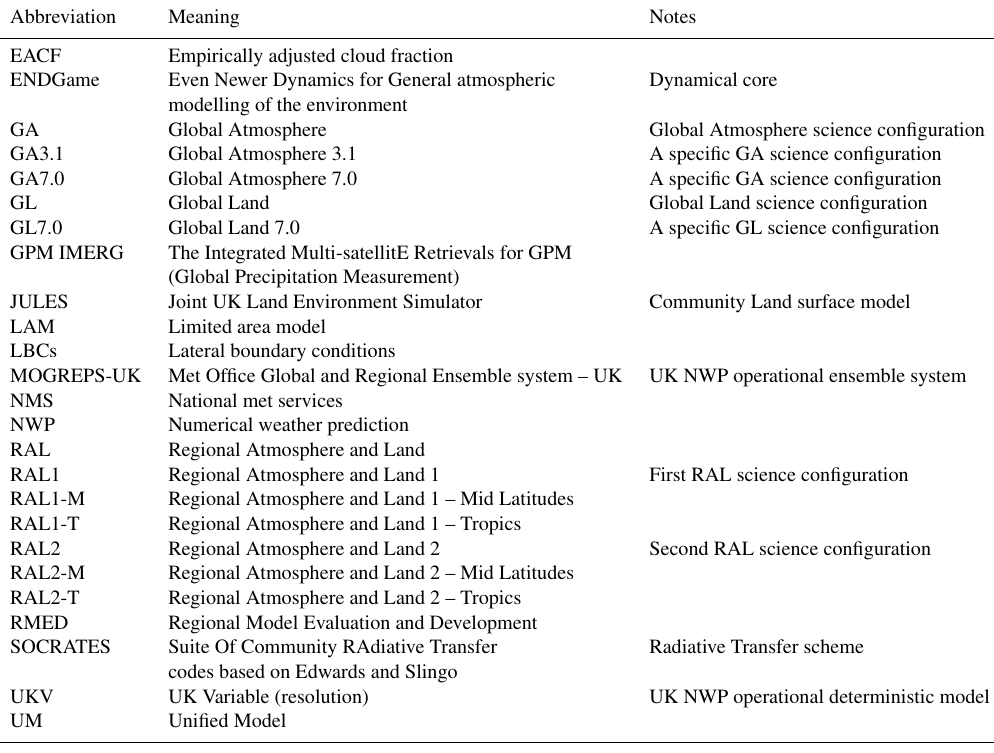
Table A2. List of abbreviations.